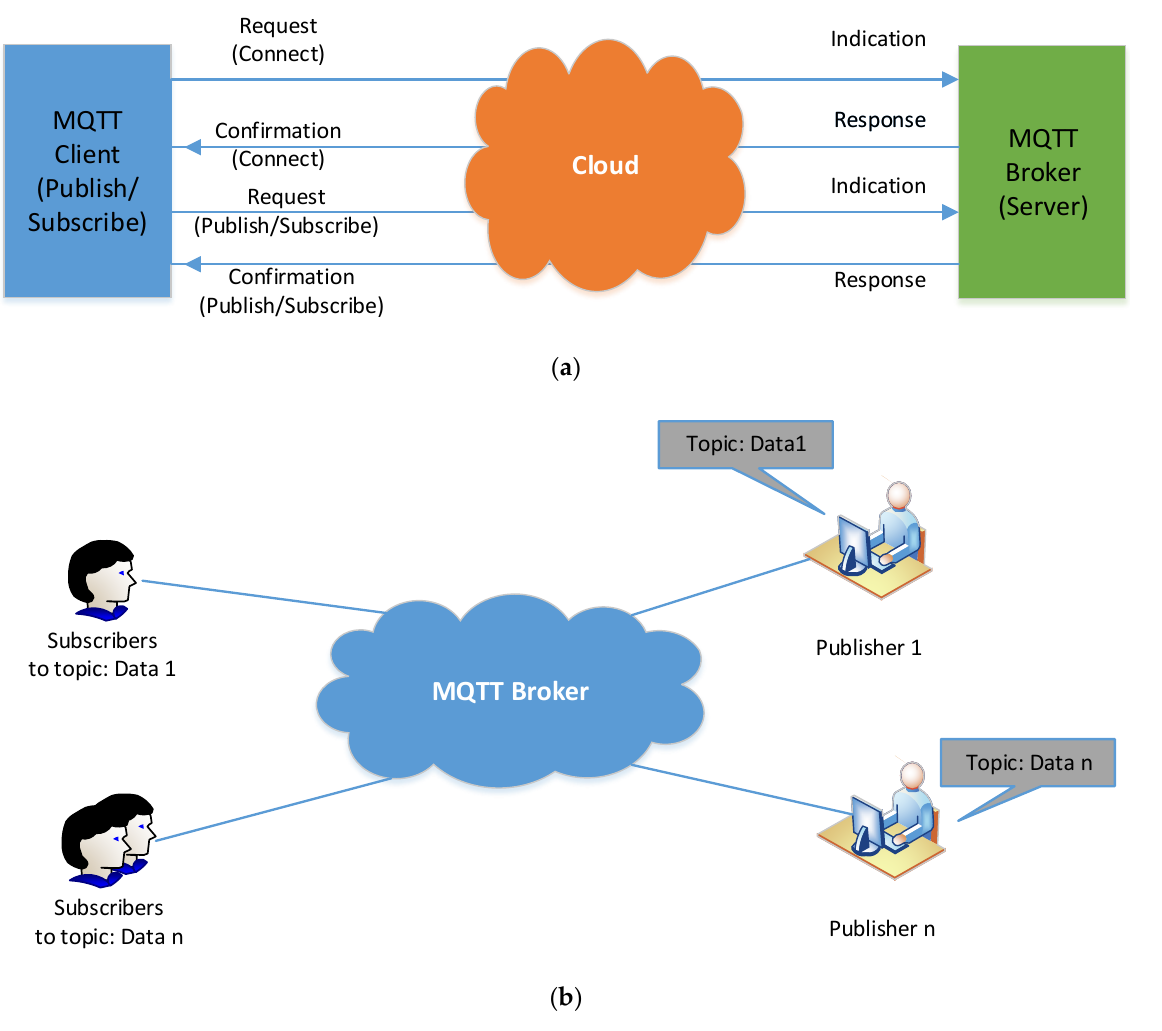
Figure 9. ( a ) MQTT Procedure, ( b ) MQTT Topic and Component.